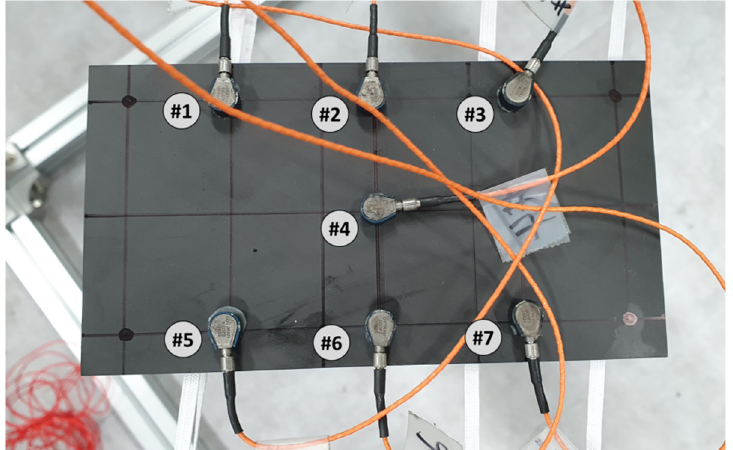
Figure 6. Test setup for the CFRP specimen, including sensor locations and free-free boundary condition. Table 2. Modal parameters of the five CFRP specimens from the experimental modal